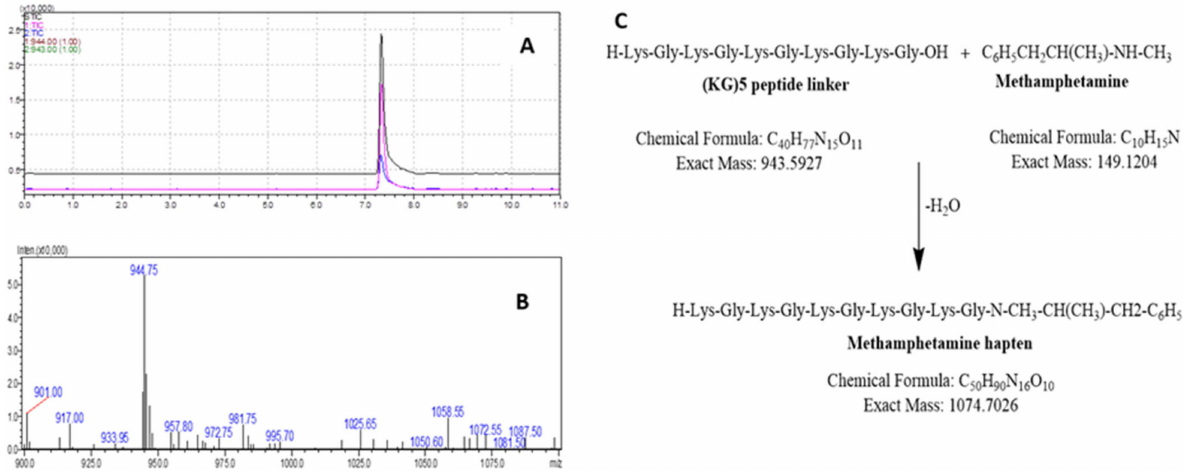
Figure 4. LC-MS method suitability check for METH hapten analysis. ( A ) Representative chro- matogram of (KG) 5 standard in SIM mode, ( B ) Representative mass spectrum of (KG) 5 , ( C ) Reaction scheme between METH and (KG) 5